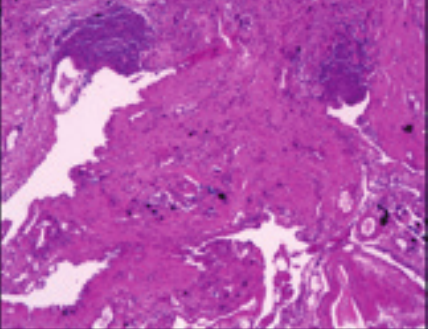
Figure 2: Histopathology of the biopsy showed inflammatory cell infiltration in the left upper lobe and fiber-vessel